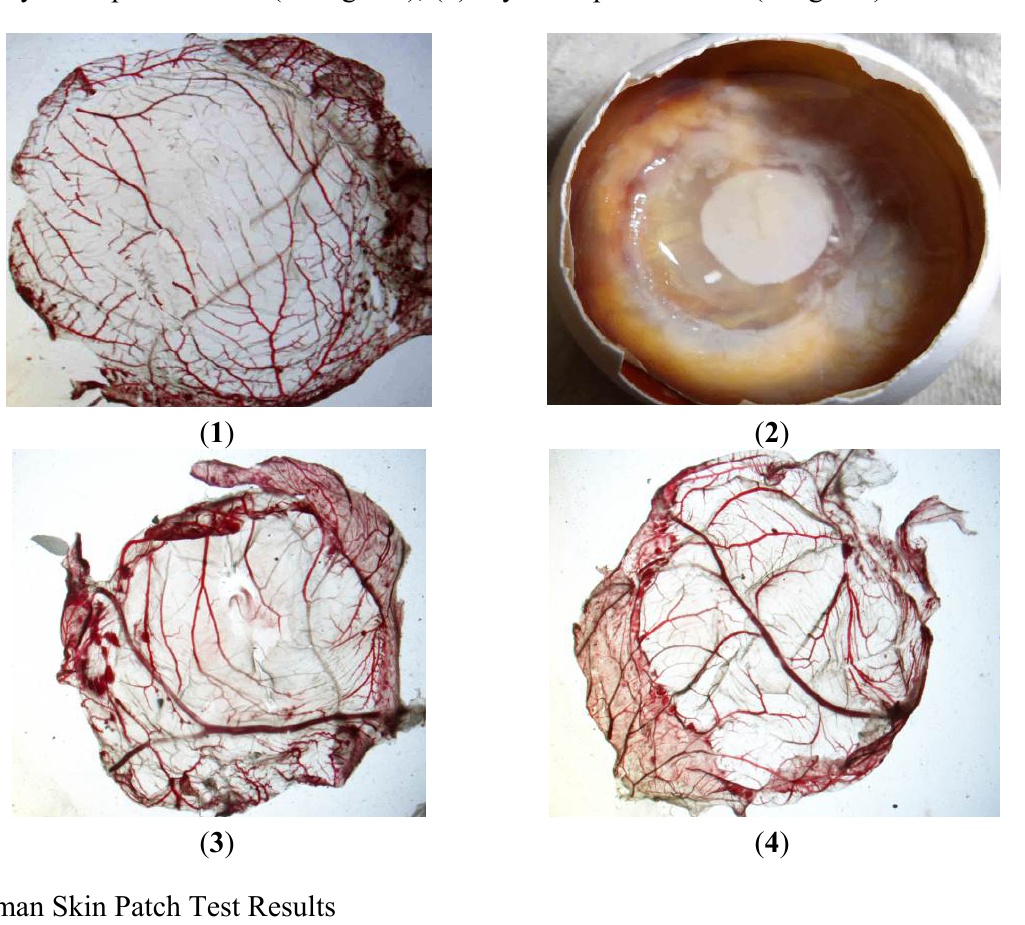
Figure 6. Photographs from CAM assay taken during vascular morphological observation of chick embryos: ( 1 ) negative control (0.9% normal saline); ( 2 ) positive control (0.4%